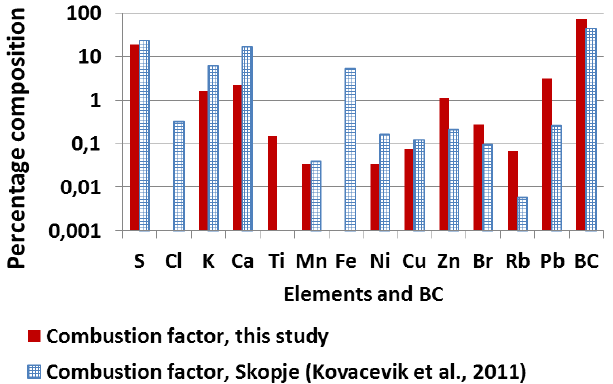
Figure 12. Percentage contribution of source factors from PMF analysis to PM 2 . 5 collected in Nairobi, Kenya. Traffic and mineral dust factors are major contributors to airborne particulate pollutants.